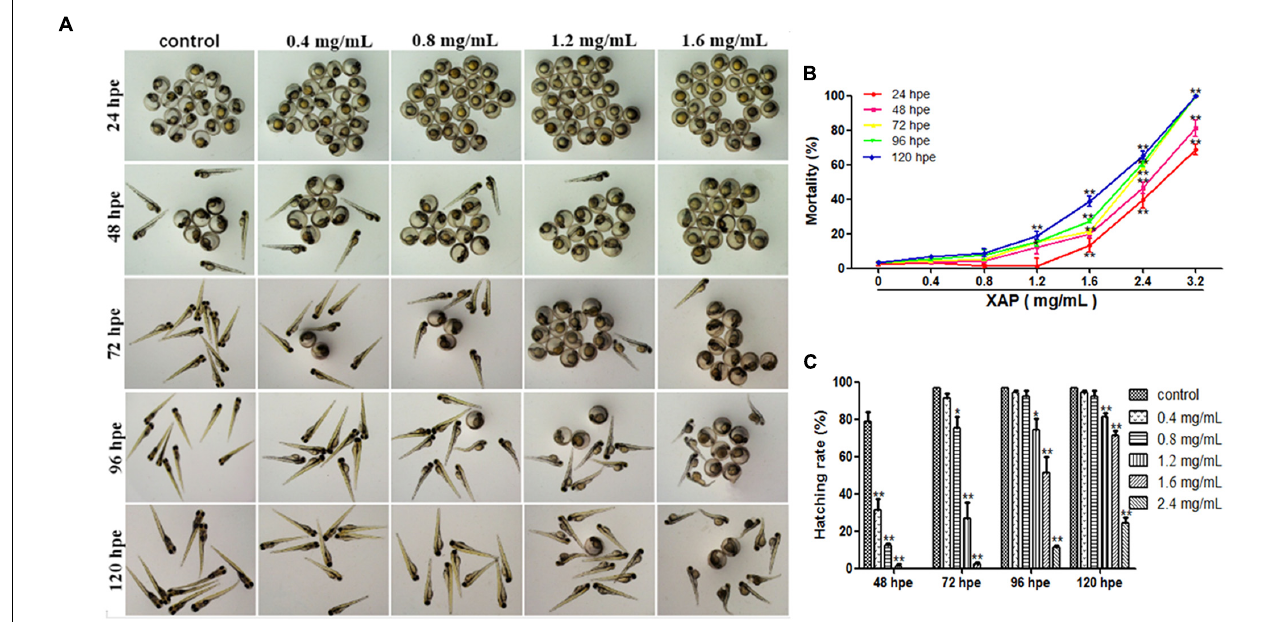
FIGURE 1 | Phenotypes, mortality, and hatching rate of embryos following aqueous exposure to XAP from 24 to 120 hpf. (A) The phenotypes of embryos in the unexposed group and XAP exposure groups. (B) The mortality rate in zebrafish embryos exposed to XAP. (C) The hatching rate in zebrafish embryos exposed to XAP. ∗ P < 0.05, ∗∗ P < 0.01 versus